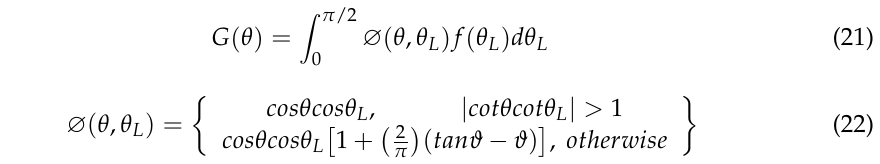
Table 4. Leaf inclination angle distribution (LAD), leaf inclination angle distribution function (LADF), average leaf inclination angle (ALA) and matched vegetation types. Measured ALA Matched LAD LADF ALA ( ◦ ) ( ◦ ) Vegetation Types 1 erectophile 2(1 − cos(2 θ ))/ π 63.24 67.4 GRA plagiophile 2(1 − cos(4 θ ))/ π 45 48.5, 36.9, 41.2 ENF, DBF, CRO spherical sin( θ ) 57.3 48.2, 52.1 SAV,